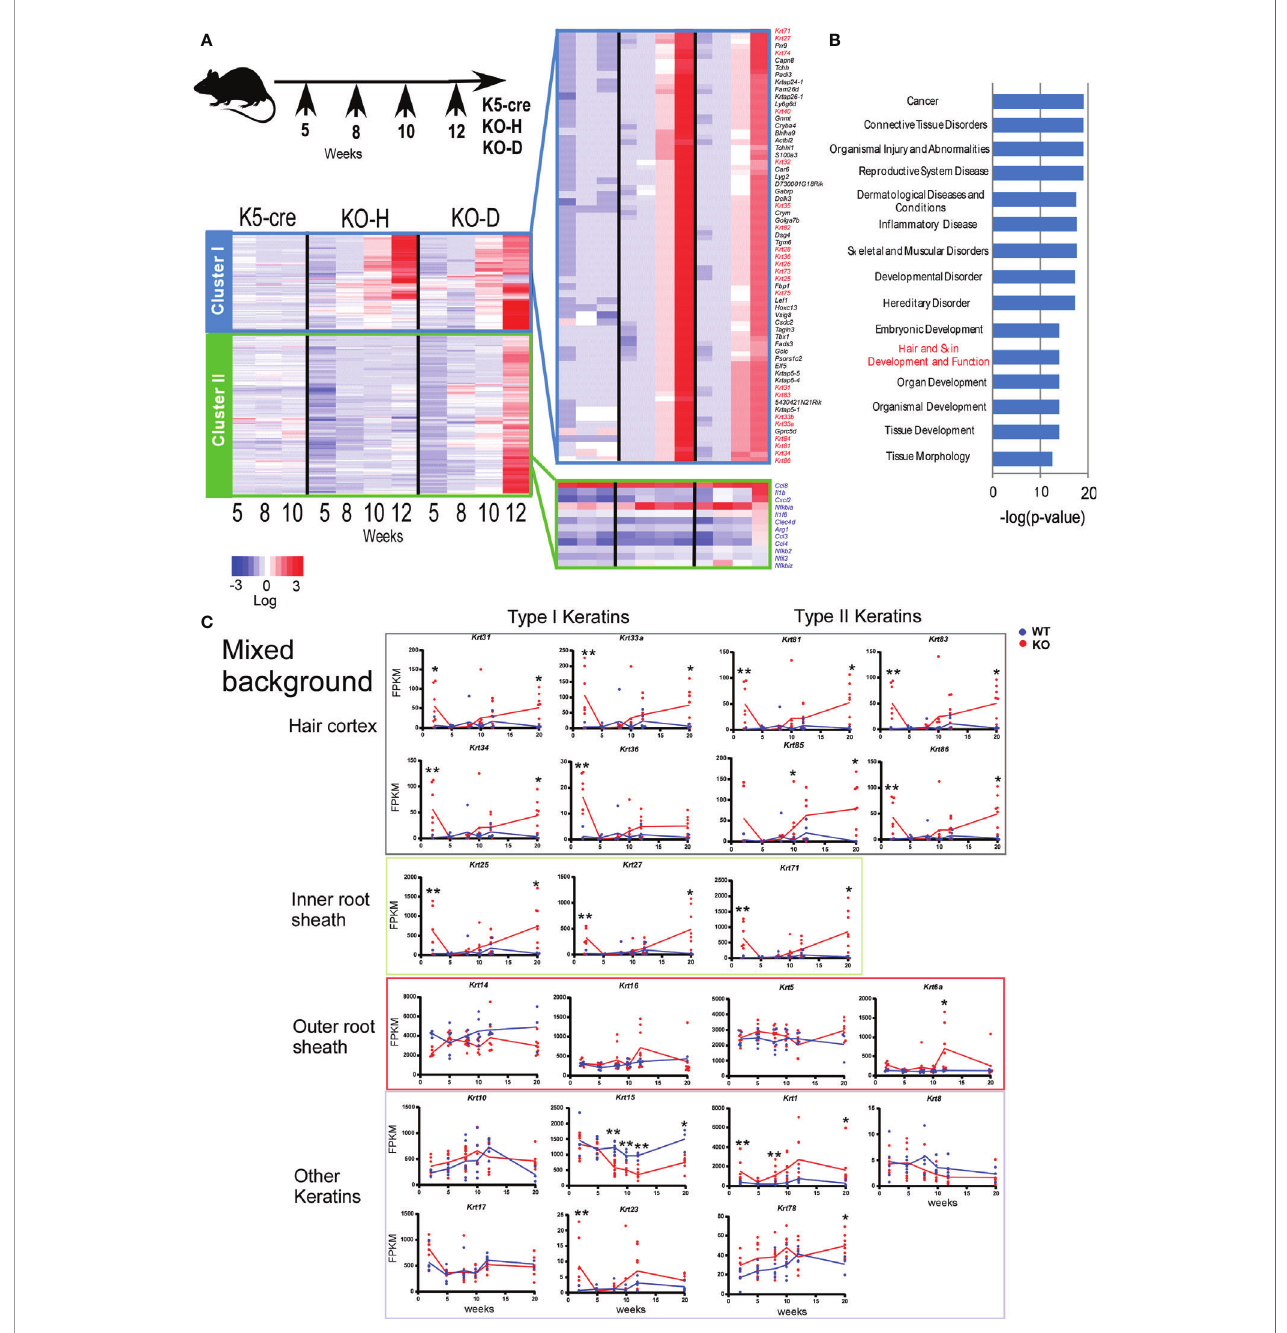
FIGURE 2 | Clustering of gene expression pro fi les of ear skin from K5-cre and Stat3 D K5 mice. (A) Stat3 D K5 mice were divided into two groups based on disease onset as follows: healthy with no dermatitis until 20 weeks (KO-H) and disease onset mice (KO-D) (top). Total RNA was isolated from the ears of individual mice, speci fi cally K5-cre (n=2), KO-H (n=5), and KO-D (n=6), at 5, 8, 10, and 12 weeks of age and analyzed by RNA-seq. The 2,064 differentially expressed genes (DEGs) in control and Stat3 -de fi cient cells (p<0.05, FPKM>2.0) were extracted by comparing the expression values among the K5-cre, KO-H, and KO-D groups at each indicated week, and clustering analysis was performed using Ward ’ s method based on the chronological change. The gene groups belonging to the two clusters were determined by gene expression changes over time. Finally, expression values of the genes in each cluster were aligned in the graph for visualization as heat maps. Keratin genes are indicated with red. Genes associated with Toll-like receptor (TLR) – NF- k B pathways are indicated with blue. (B) The top 15 ranking pathways in the Ingenuity Pathway Analysis (IPA) of DEGs in cluster I are shown with p-values. (C) The expression pro fi les of hair follicle (HF)-speci fi c or other keratin genes in the ear skin of mixed background WT (n=7) or Stat3 D K5 (KO, n=7) mice bred under speci fi c pathogen-free (SPF) conditions. The blue and red lines indicate means for WT and KO, respectively. *p < 0.05, **p <